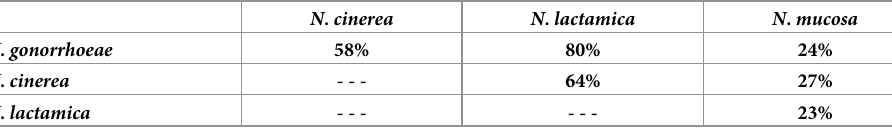
Table 3. Sequence identity of different Neisseria PorB